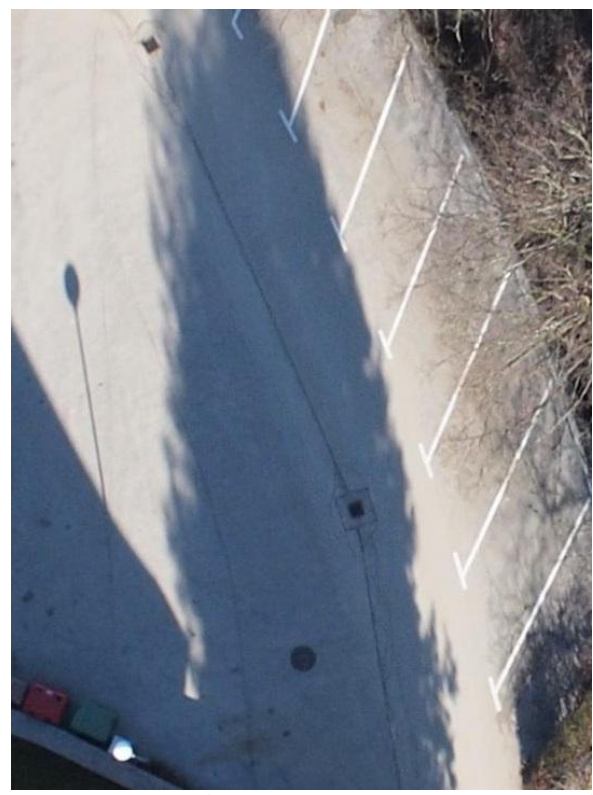
Figure 8. A subset of orthophoto map with ground pixel size of 3